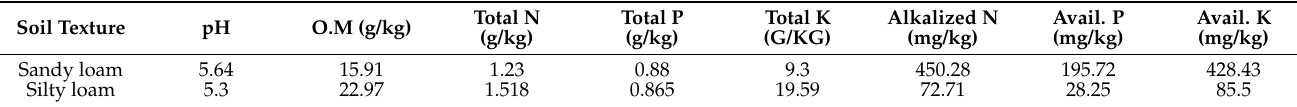
Table 3. Results of soil chemical